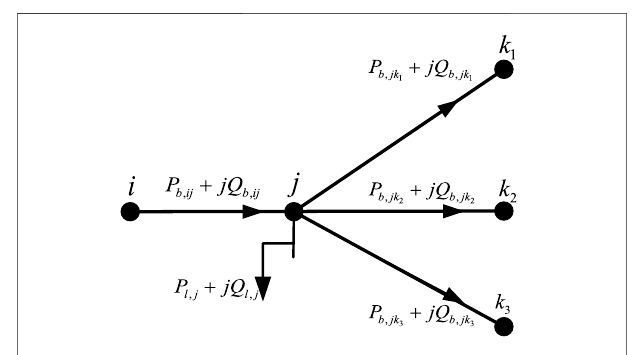
FIGURE 5 | Radial network with active power fl